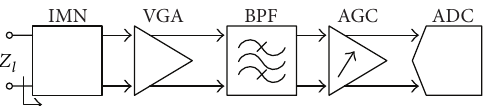
Figure 2: Block diagram of the PLC receiver AFE